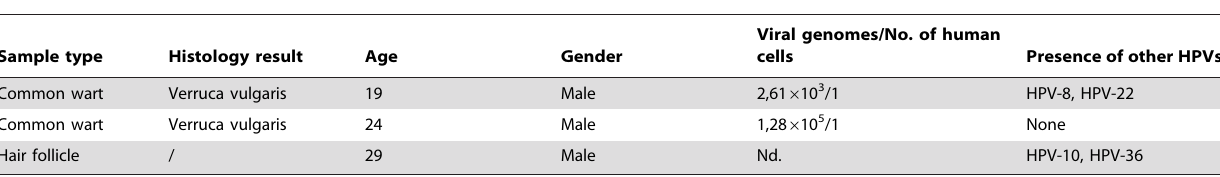
Table 3. Characteristics of HPV-125 positive samples and